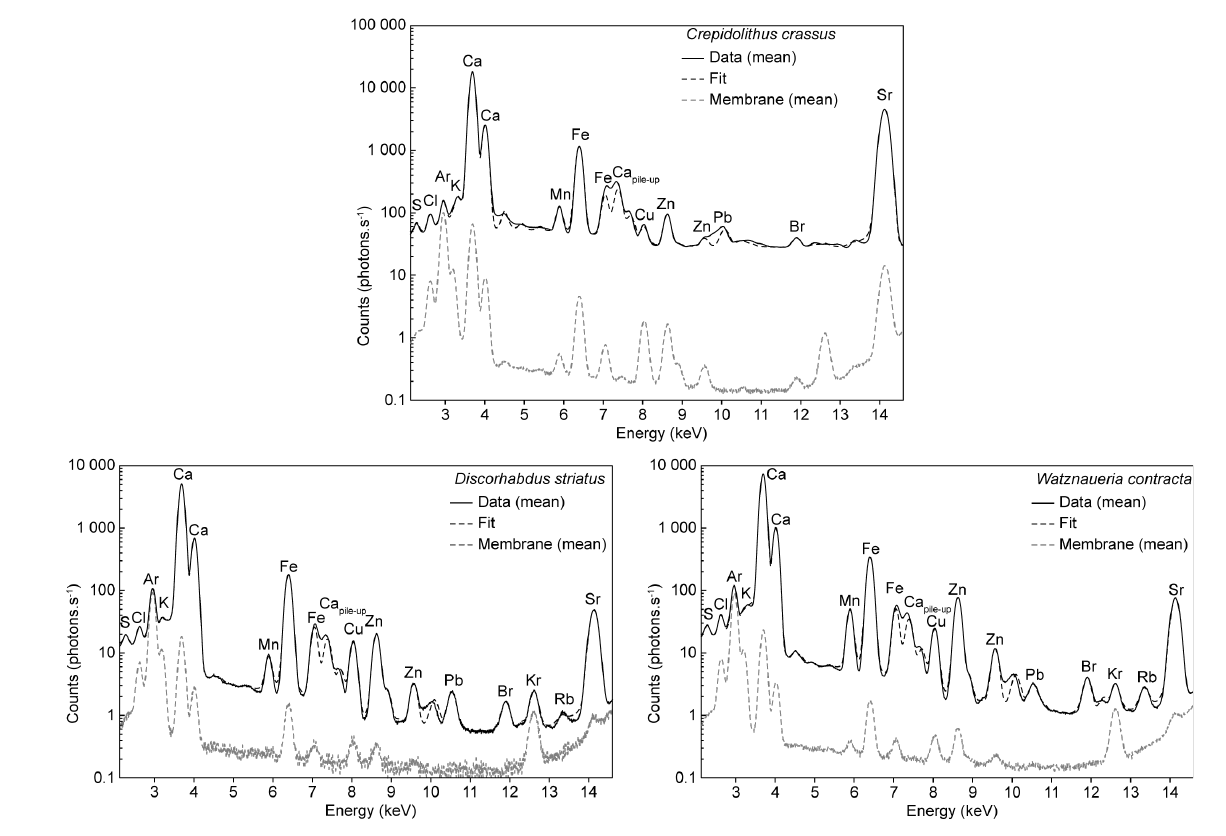
Figure 1. Mean XRF spectra of C. crassus , D. striatus and W. contracta coccoliths and associated membrane spectra. Ca pile-up correspond to the quantification of two Ca energy summed arriving at the same time in the captor. Ar is the same in coccolith and membrane because it corresponds to the air in the experimental hutch. In the three coccoliths, membrane contribution in Ca, Fe, Cu and Zn and in Sr in C. crassus is observed. However, it is always two order of magnitude below the concentration in the coccolith thus membrane contribution represents less than 1% in those